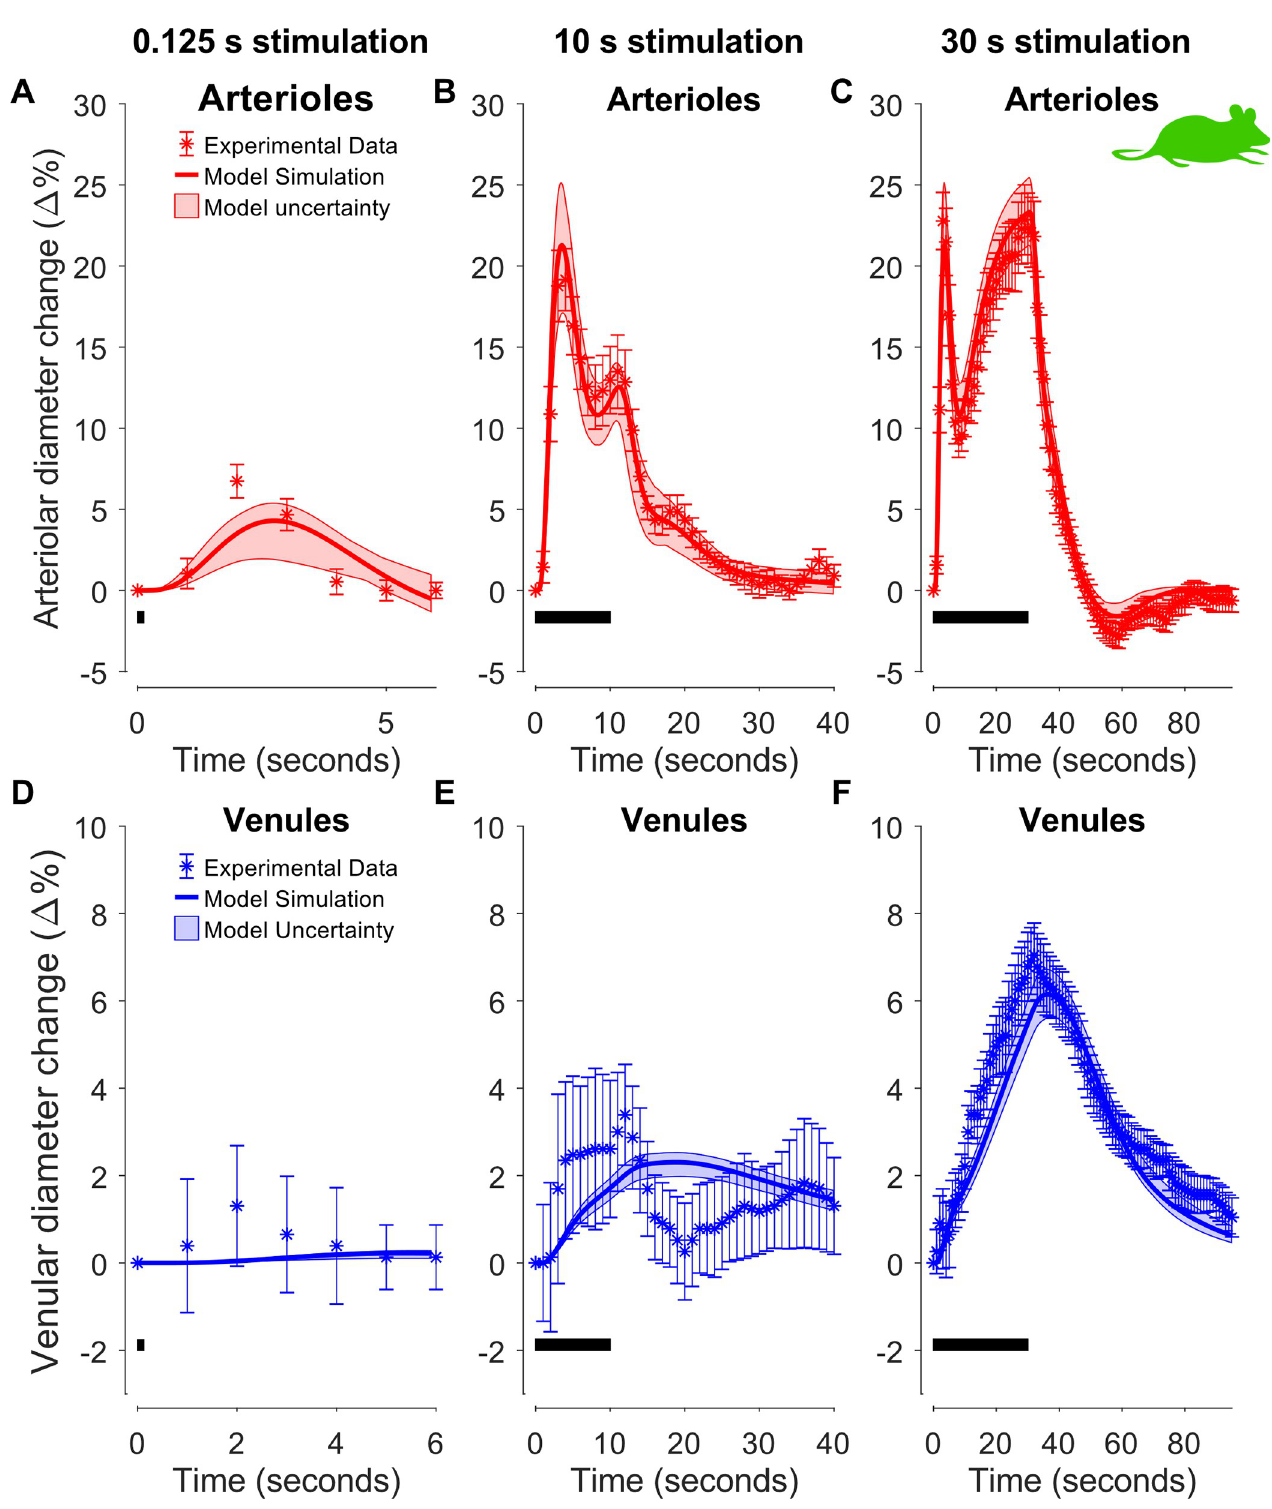
Fig 3. Model estimation to experimental data in Section 2.1.1. Data and simulations for arteriolar (A–C) and venular (D–F) diameter changes in awake mice for three different sensory stimulation lengths: 125 ms (A & D), 10 s (B & E), and 30 s (C & F). Experimental data are replotted versions of data presented in Fig 2C of the original manuscript by Drew et al. [46]. The stimulation lengths are denoted with the black bar in the bottom left portion of each graph. For each graph: experimental data (colored symbols); the uncertainty of the experimental data is presented as the standard error of the mean (SEM) (colored error bars);